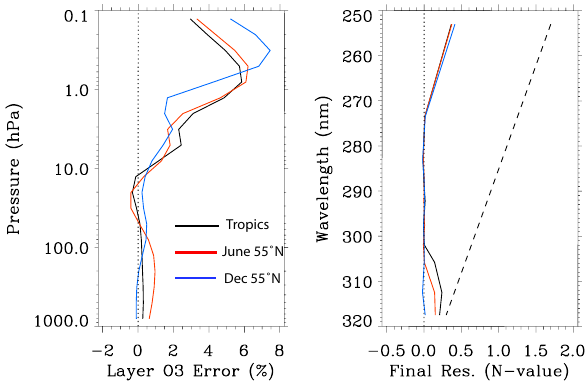
Figure 13. Left panel shows error in layer O 3 caused by 0.05%/nm linearly varying error in NOAA-17 SBUV radiances, assuming zero error at 331nm (where ice radiances are used to stabilize instrument calibration) and 4% error at 252 nm (shown as dashed line on the right panel in N-value unit). At higher altitudes the errors vary with SZA due to change in layer DFS shown in Fig. 5. Right panel shows the final residuals (difference from measured and calculated radiances) in N-value (1N= -2.3%). The residuals are non- zero at wavelengths not used by the algorithm allowing one to monitor such errors.